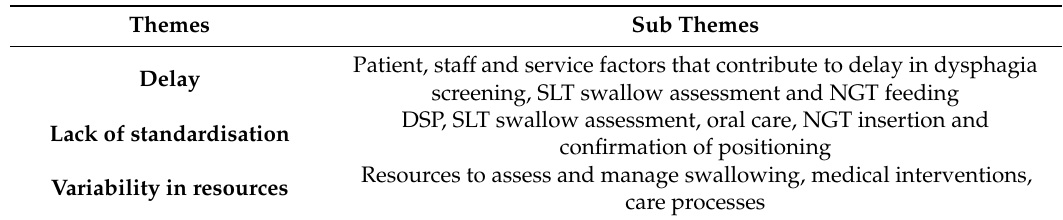
Table 1. Themes and sub